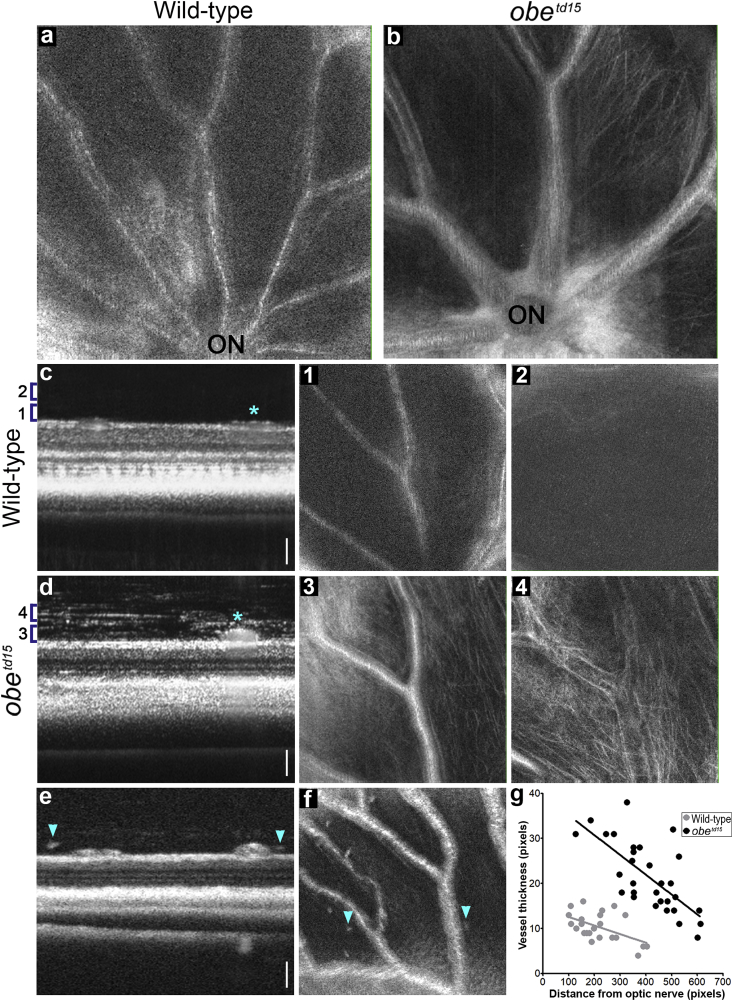
Retinal vasculature in obetd15 zebrafish.OCT en face images of the dorsal retina show inner retinal vessels emerging from the optic nerve region in the wild-type (a) and obetd15 (b) fish at 12 months post-fertilization, displaying abnormal blood vessel appearance in the mutant retina. Cross-sectional B-scans from wild-type (c) and obetd15 (d) fish also demonstrate notable differences in vessel size (vessels indicated with *). Numbered brackets (1–4) on the cross-sections represent areas analyzed in the corresponding en face images. Fibrous material was apparent at each depth examined in the vitreous of the obetd15 retina (3, 4) but was not seen on the wild-type images (1, 2). Hyper-reflective deposits were also noted in the vitreous of the obetd15 retina on both B-scan (e) and en face (f) images, indicated with arrows. Graph (g) shows retinal vessel thickness plotted against distance from the optic nerve in wild-type and obetd15 zebrafish. Scale bars = 50 μm.